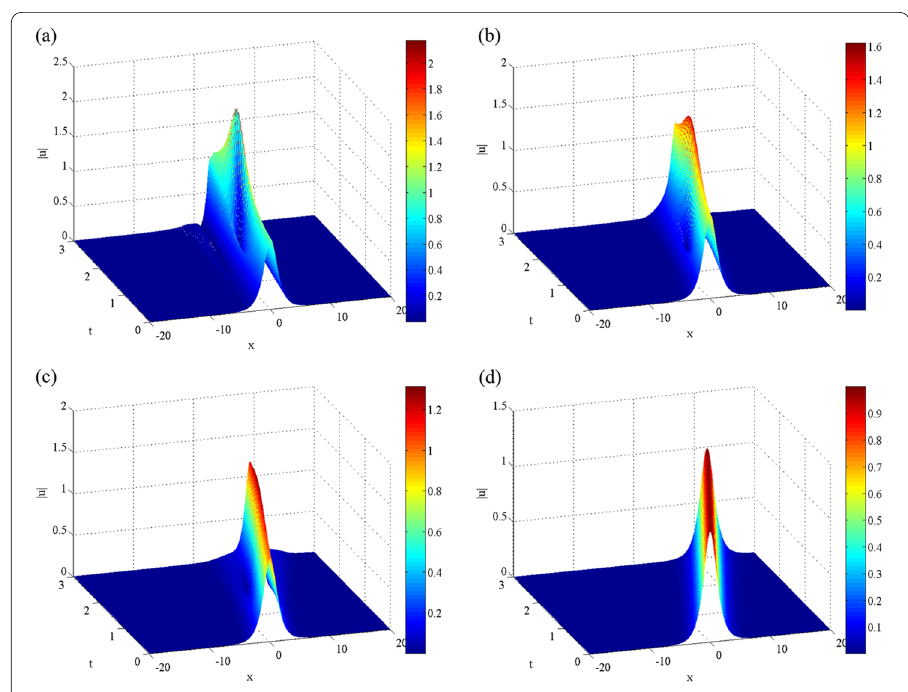
Figure 1 The wave propagations for different α with γ = 1, λ = 2; ( a ): α = 0.6, ( b ): α = 0.8, ( c ): α = 0.9, ( d ): α =